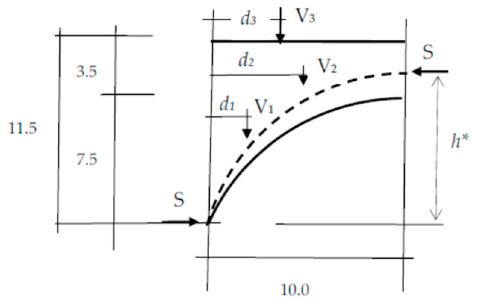
Figure 11. Scheme of the pointed